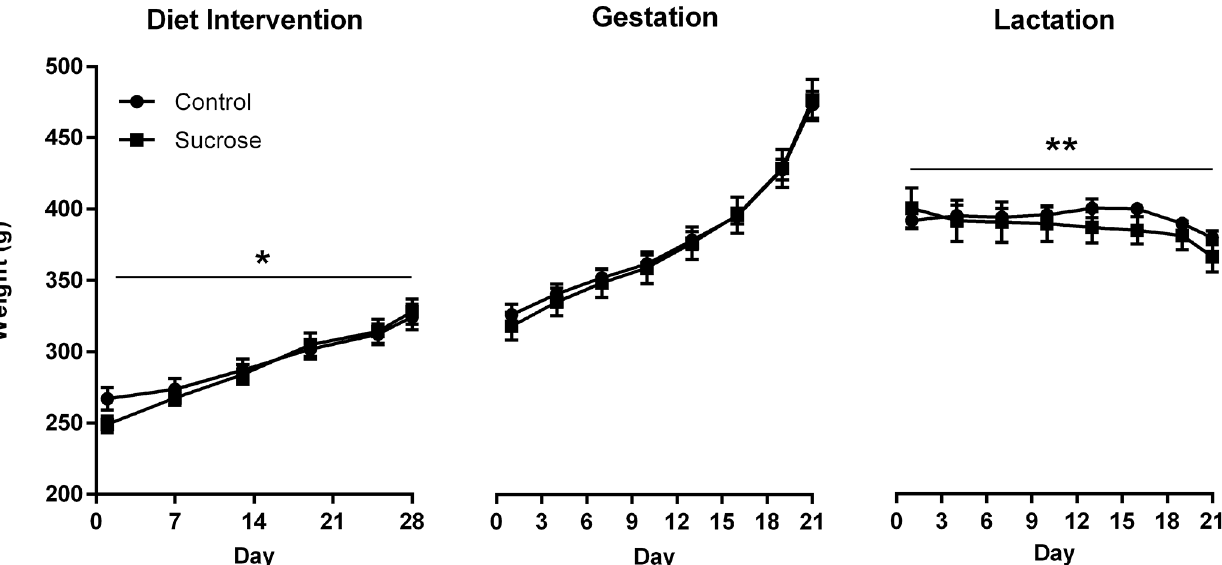
Fig 1. Body weights of female rats across the diet intervention, gestation, and lactation. Rats in the Sucrose group had free access to 10% sucrose solution during the 28-day diet intervention and during gestation, with access ceasing at parturition (P). Data are group means ± SEM, with n = 12 for the diet intervention phase and n = 11 for gestation and lactation phases (1 rat from each group miscarried). Relative to Controls, the Sucrose group gained a greater proportion of starting body weight during the diet intervention, * p = .02, and lost a greater proportion of weight during lactation, ** p = .003. Groups did not differ in the rate of weight gain during